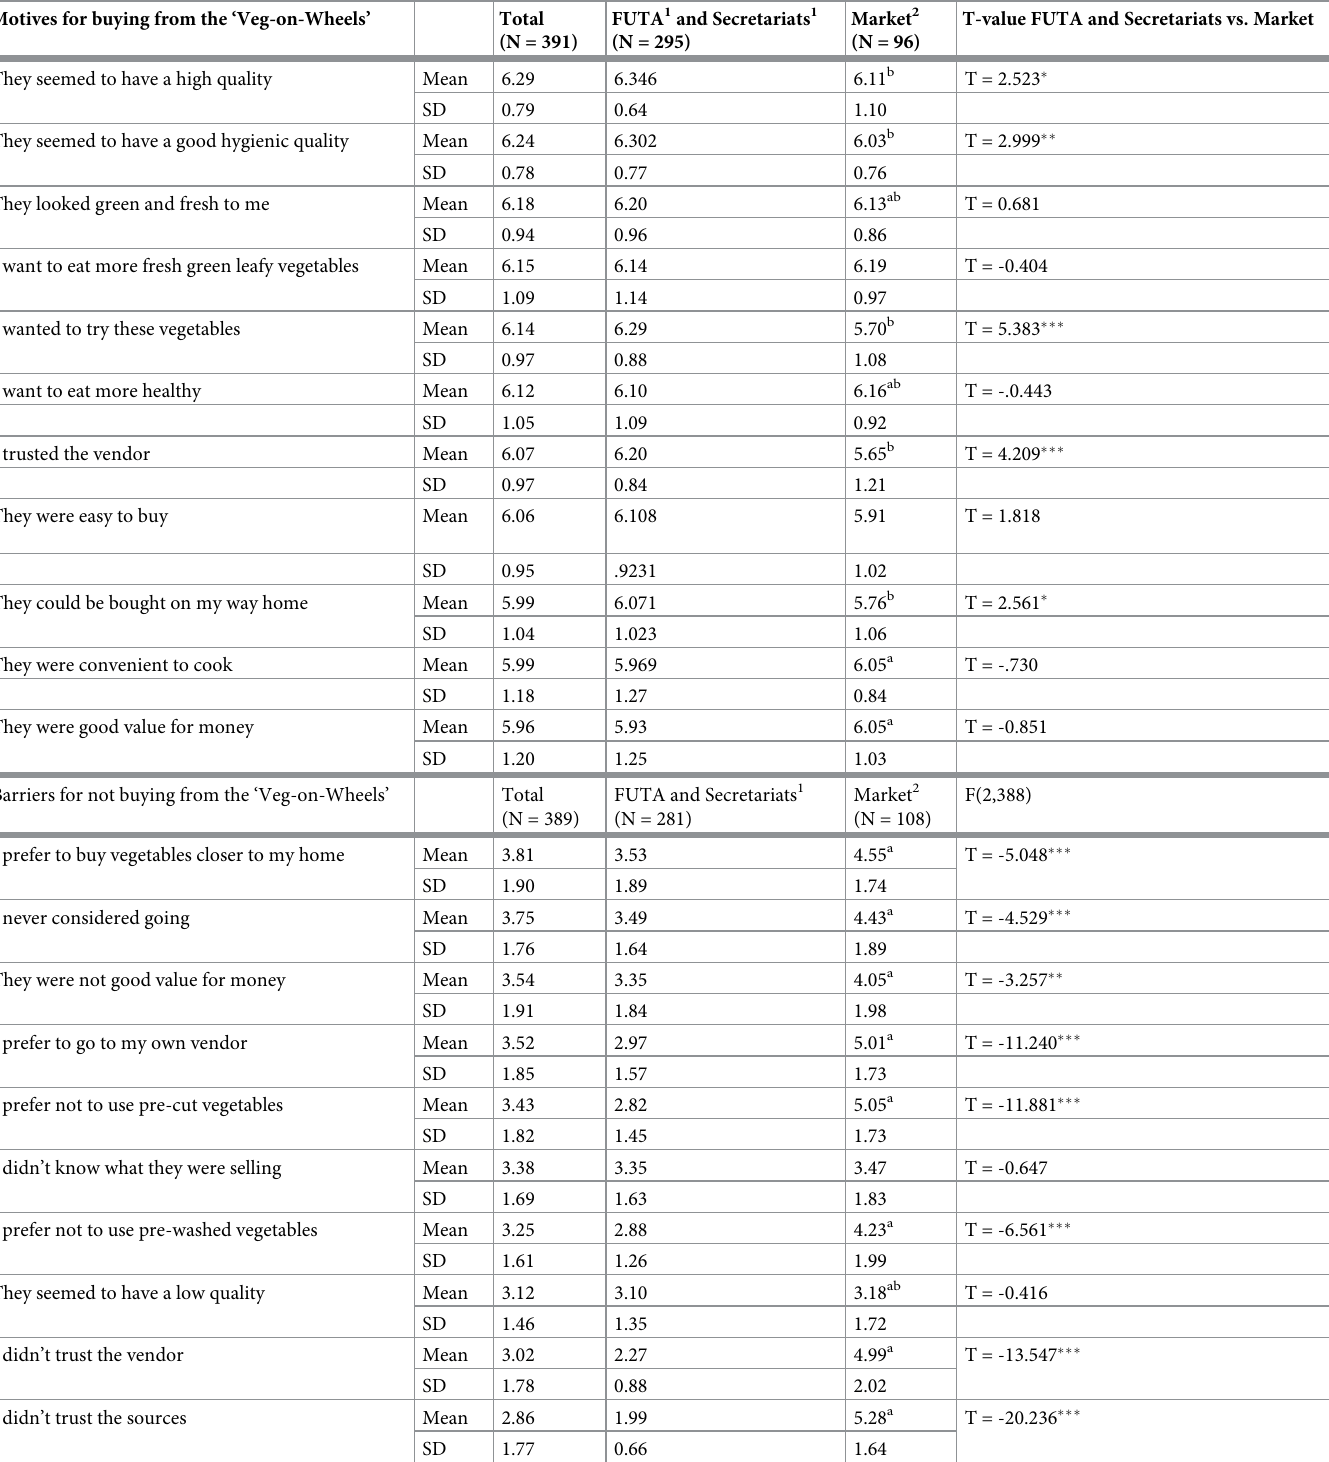
Table 5. Motives and barriers for buying/not buying from ‘Veg-on-Wheels’ (mean values). Motives for buying from the ‘Veg-on-Wheels’ Total